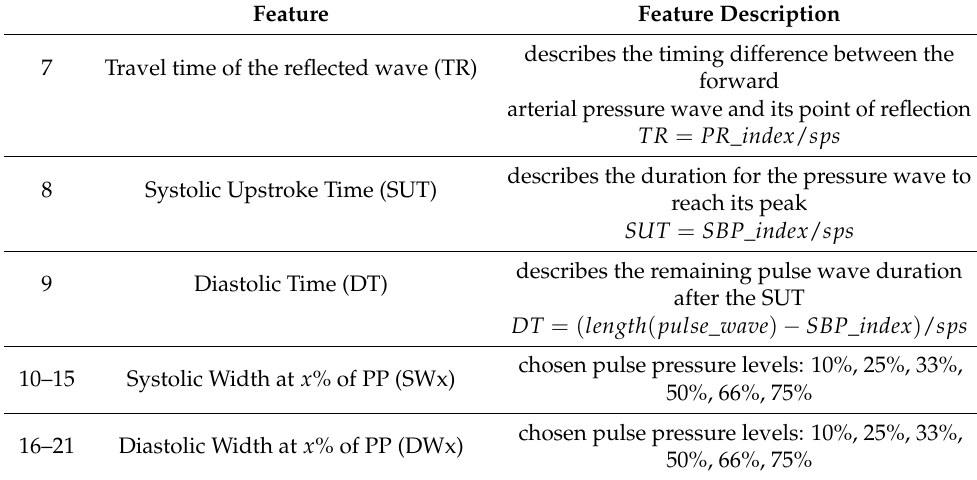
Table 2. Chosen timing-based